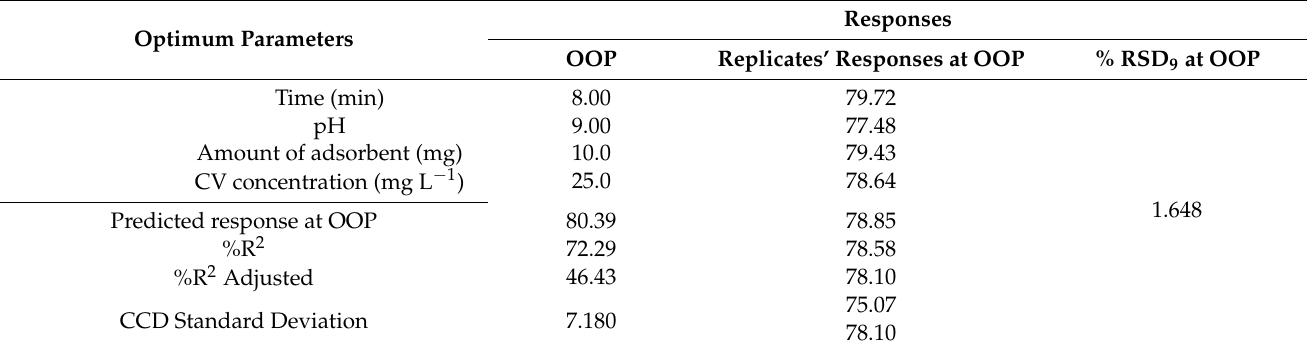
Table 3. Optimum operating parameters, model summary, and the validation of the responses at the OOP along with the RSD for the